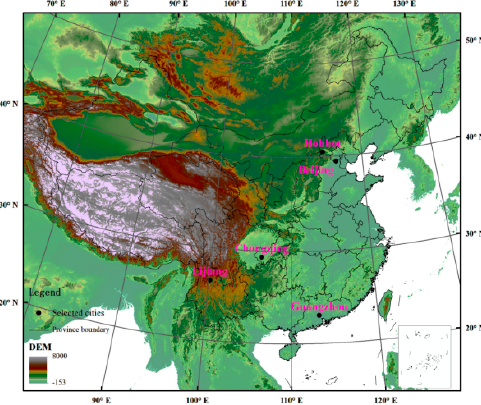
Figure 1. Geographies of the selected cities.